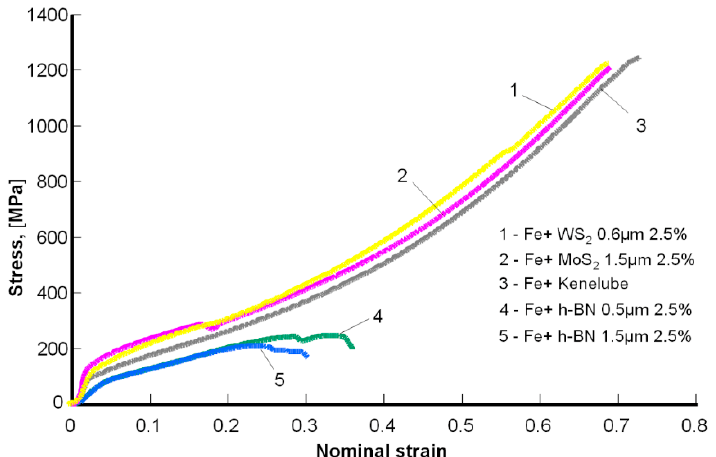
Figure 5. Compression diagram for a Fe sample with layered additives.